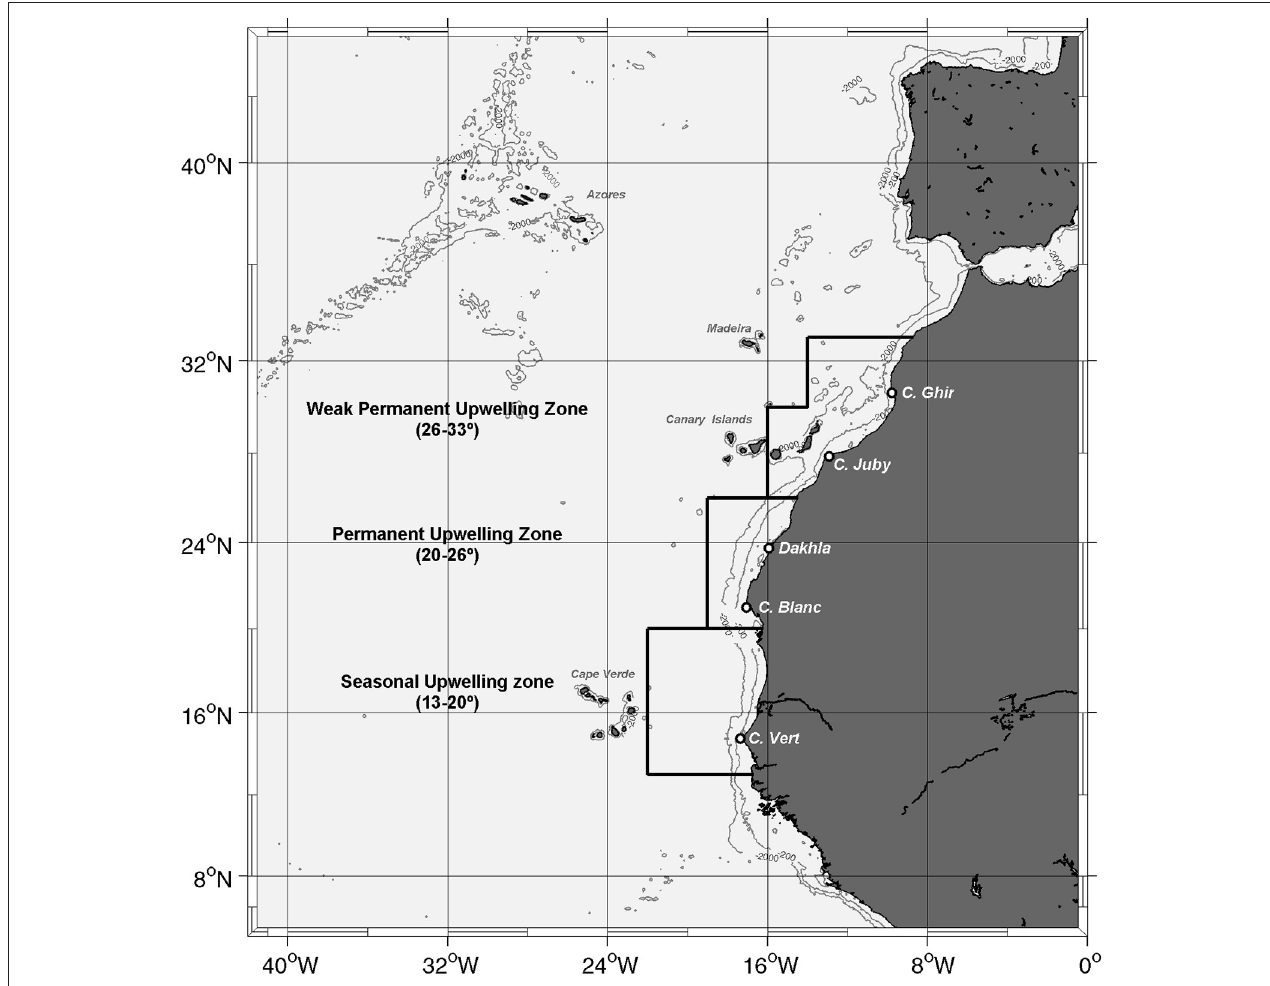
FIGURE 1 | CanC upwelling region and its main geographical features. The three upwelling subregions –the weak permanent (WPUZ), permanent (PUZ), and seasonal upwelling zones (SUZ)– are identified along with the geographical domains selected to estimate climatological anomalies (black boxes). 200m and 2,000m isobaths are represented by gray contour lines. Bathymetry data corresponds to a 2 ′ global dataset derived by Smith and Sandwell (1997).